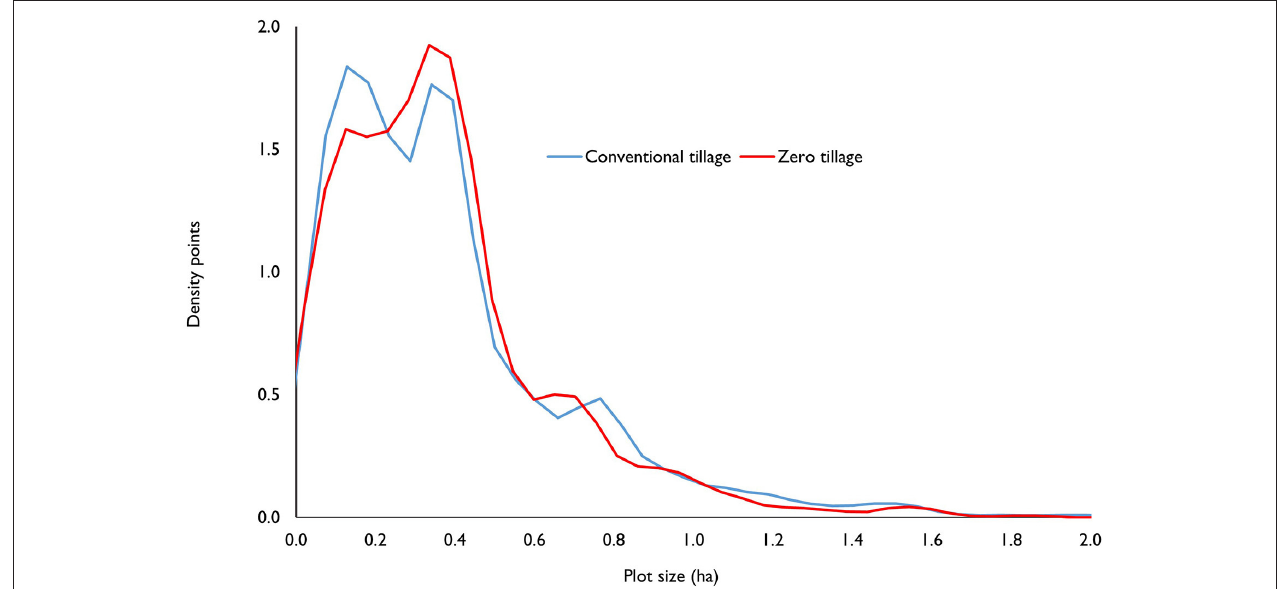
FIGURE 5 | Plot size and use of conventional and zero tillage in Punjab. Source: Remote sensing data ( n = 5,973). The difference in plot size under conservation tillage and zero tillage is statistically insignificant ( p > 0.10).